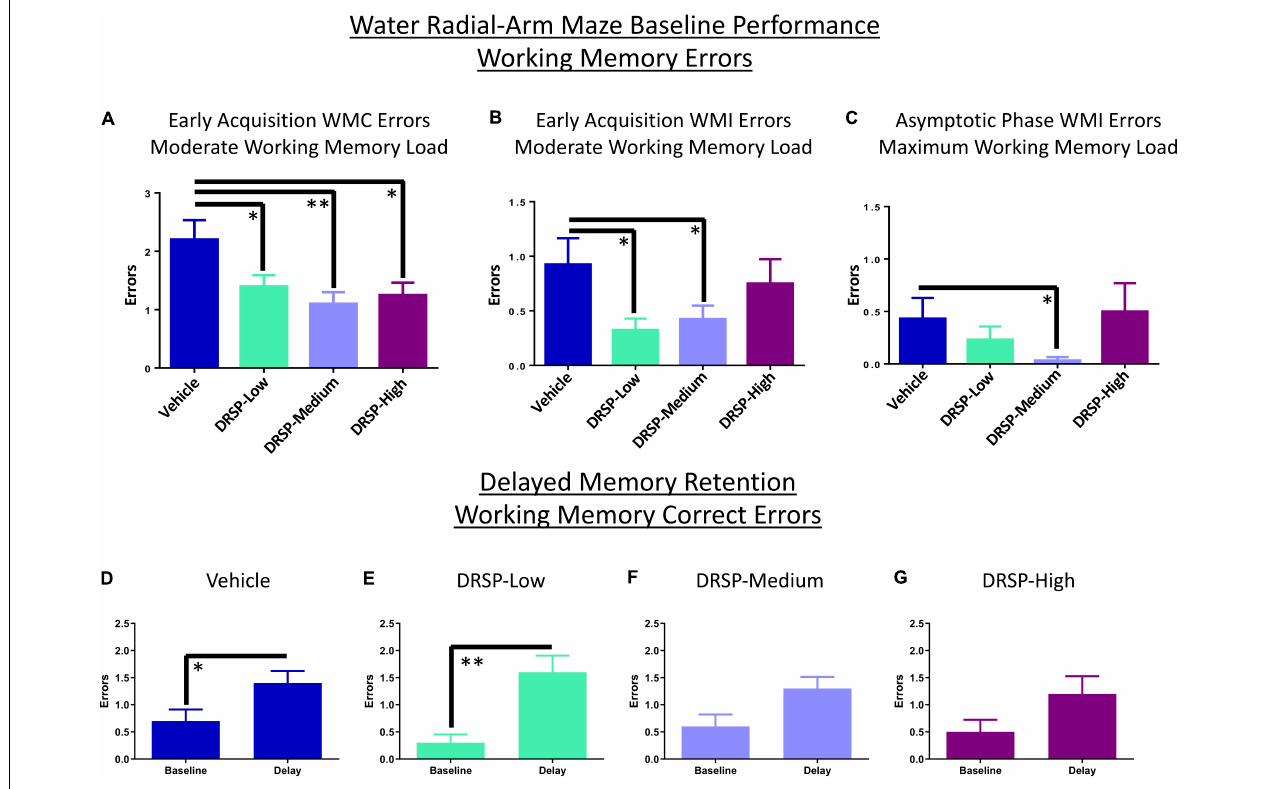
FIGURE 1 | Experiment 1 Water radial-arm maze. (A) During Early Acquisition, all groups treated with drospirenone had improved WMC performance compared to rats without hormone treatment when working memory load was moderately taxed. (B) This working memory benefit was extended to WMI errors on the moderate working memory load trial for DRSP-Low and DRSP-Medium groups compared to rats without hormone treatment. (C) During the Asymptotic Phase, DRSP-Medium continued to enhance WMI performance compared to rats without hormone treatment on Trial 4, the maximum working memory load trial. Rats treated with Vehicle (D) or DRSP-Low (E) showed impaired delayed memory retention on Trial 3 following a 6-h delay compared to the previous day’s baseline performance. Rats treated with (F) DRSP-Medium and (G) DRSP-High treatment did not exhibit a statistically significant delay-related impairment. ∗ p < 0.05 and ∗∗ p < 0.01. Vehicle n = 10, DRSP-Low n = 10, DRSP-Medium n = 10, and DRSP-High n =